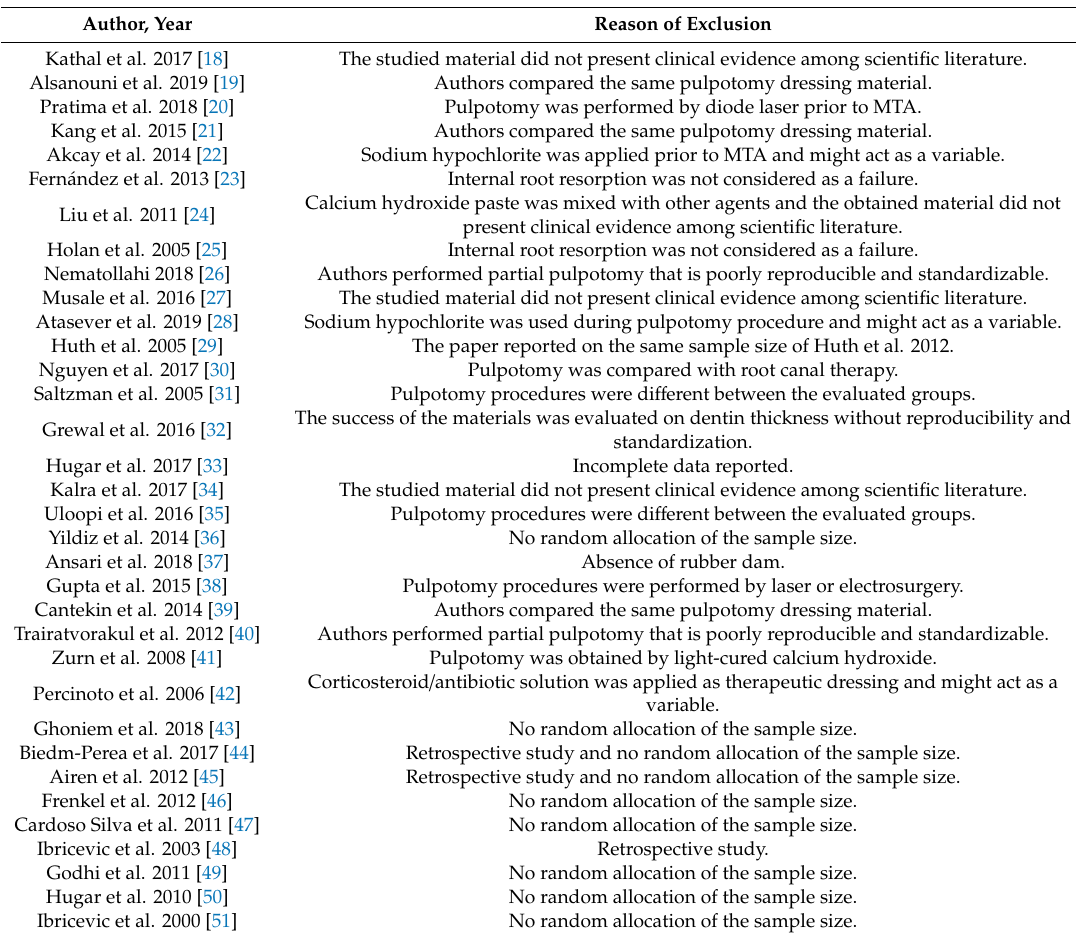
Table 1. Excluded studies and reason of